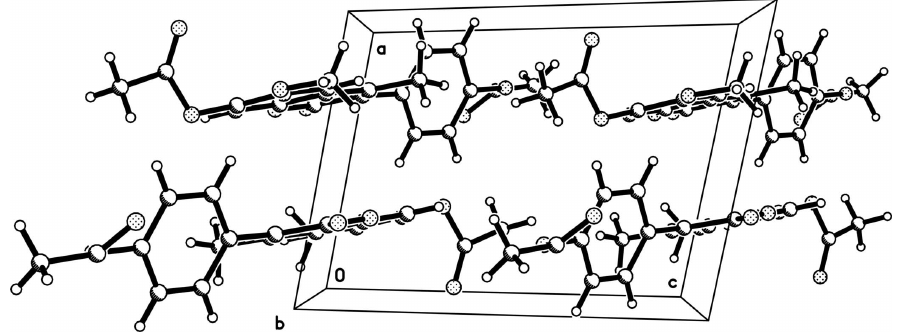
Figure 2 Packing diagram, viewed down the b